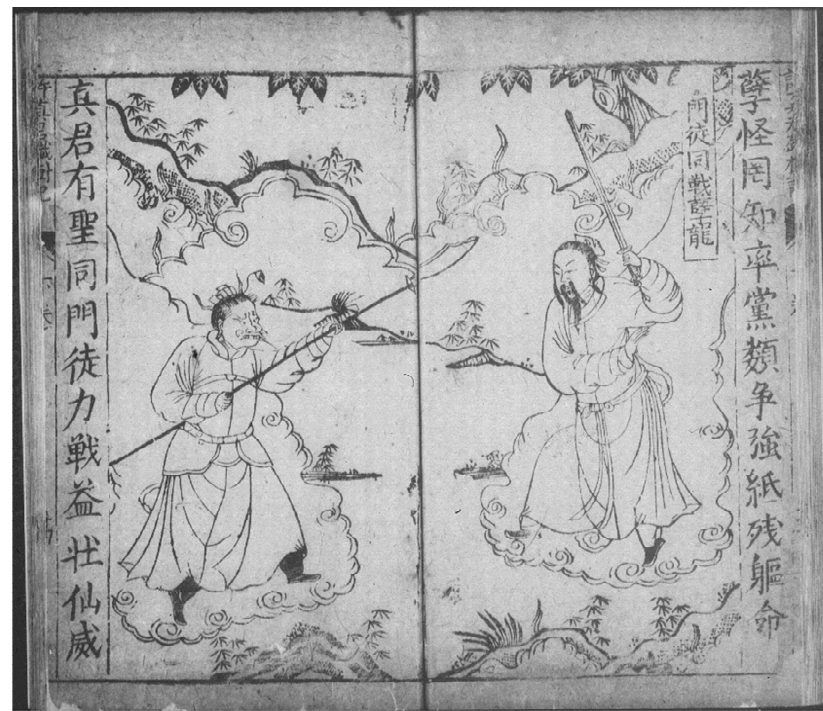
Figure 4. Xu Xun fights the dragon of Poyang Lake, The Iron Tree , 1604 edition.